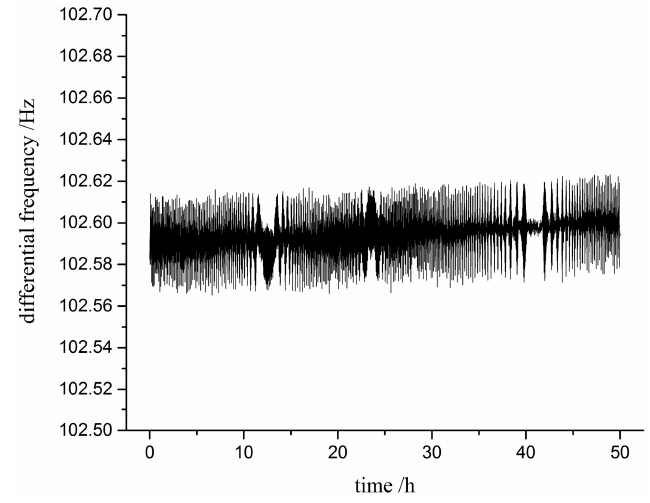
Figure 20. The fluctuation of differential frequency in 50 h.